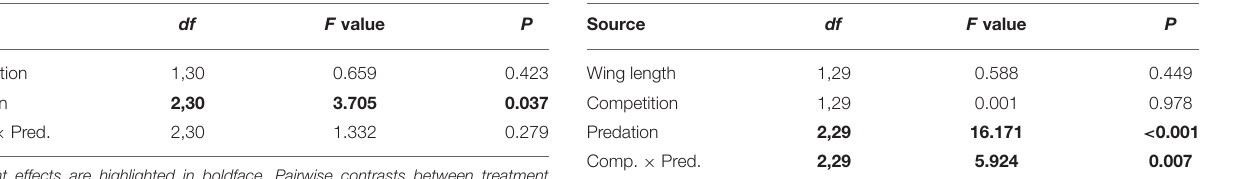
TABLE 6 | ANOVA results for number of eggs produced by Aedes aegypti in first gonotrophic cycle with wing length as the